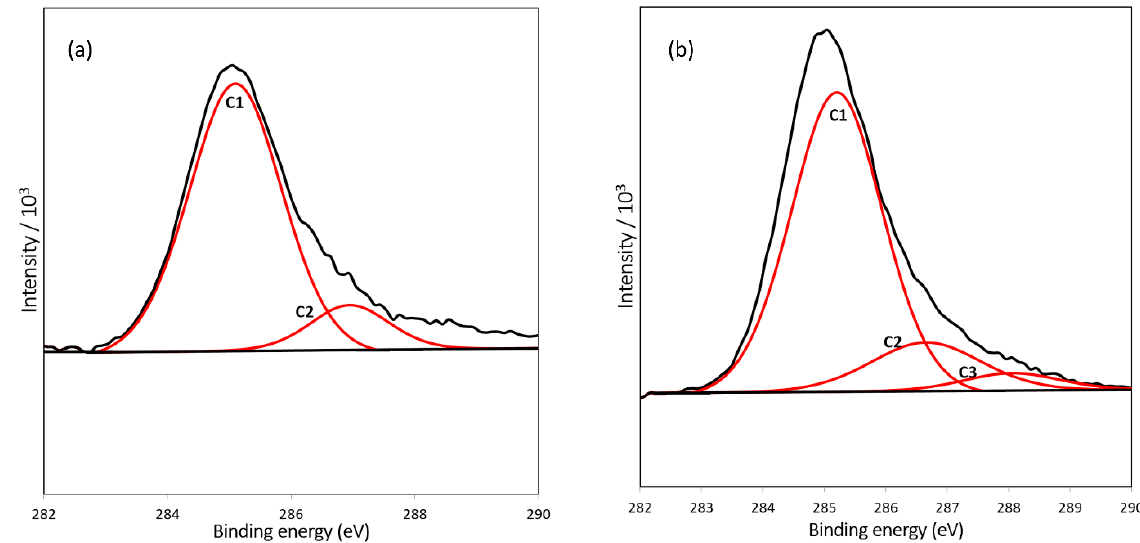
Figure 4. XPS spectra of C1s for Si surface modified with ( a ) APTES and ( b ) glutaraldehyde.